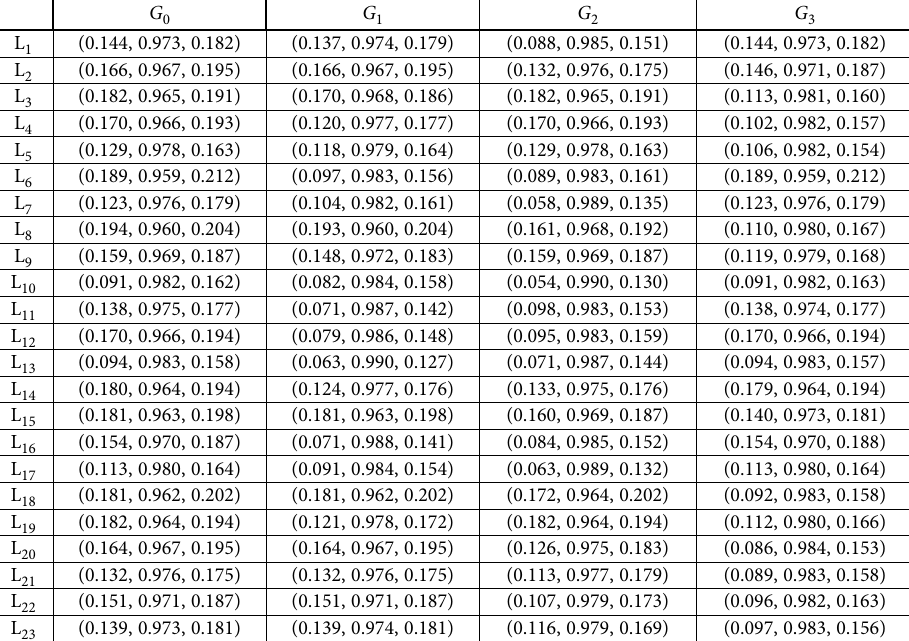
Table 9. WNAPF-DM for options over different challenges to implementing of G-IoT